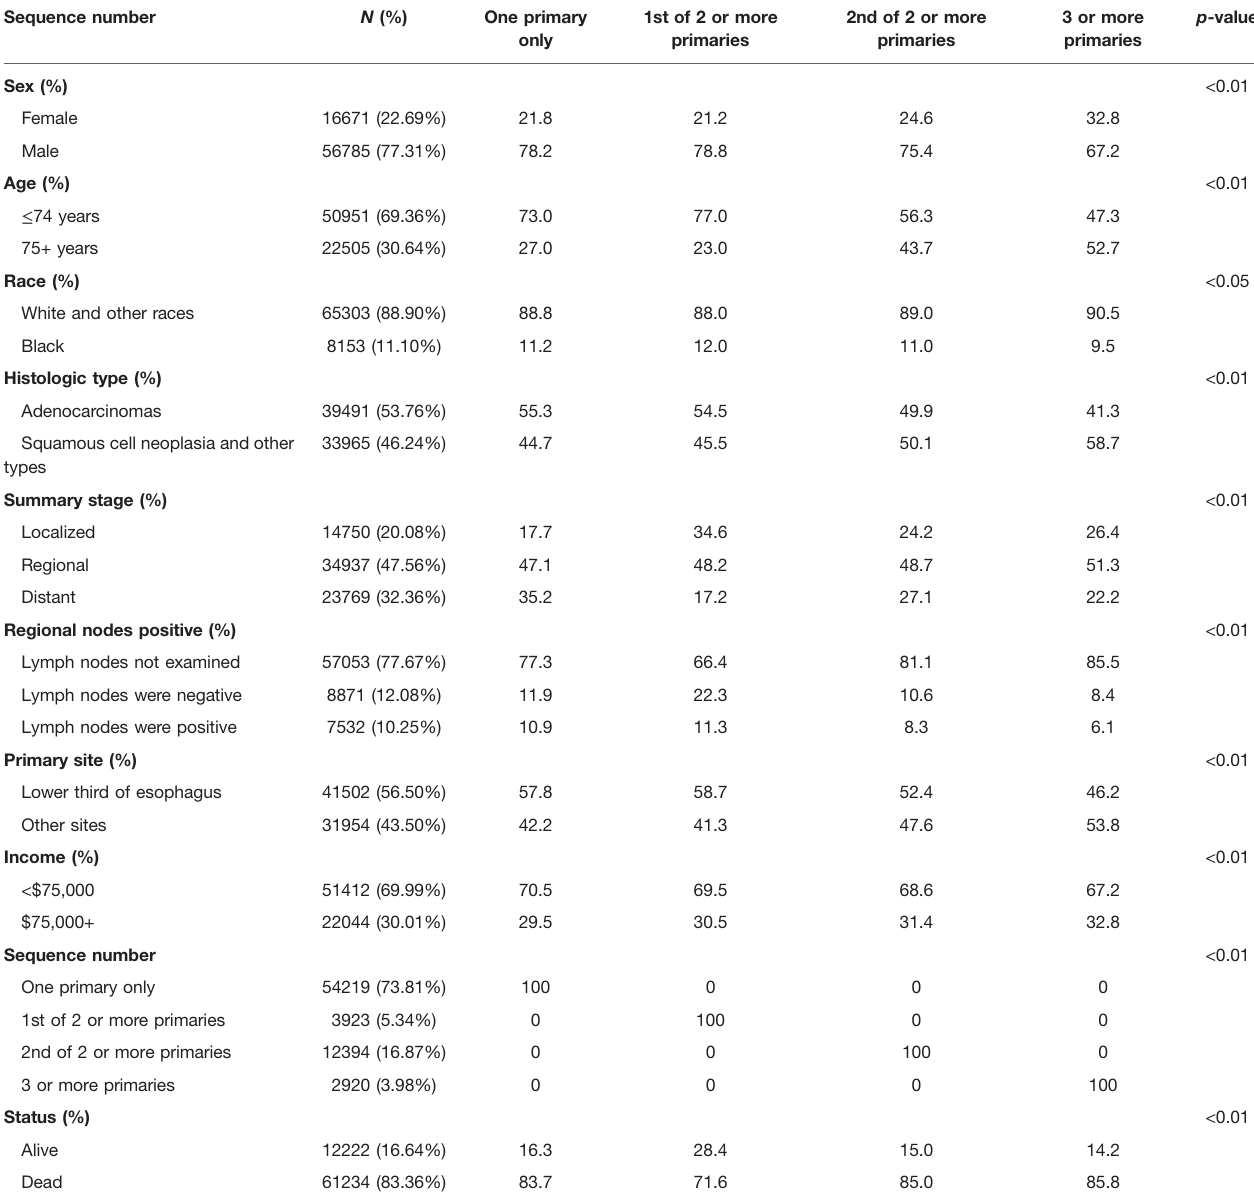
TABLE 1 | Baseline characteristics of participants ( N